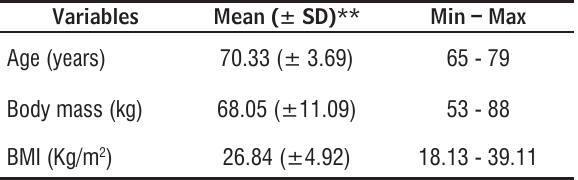
Table 1 - Anthropometric aspects of the sample (n = 30) Variables